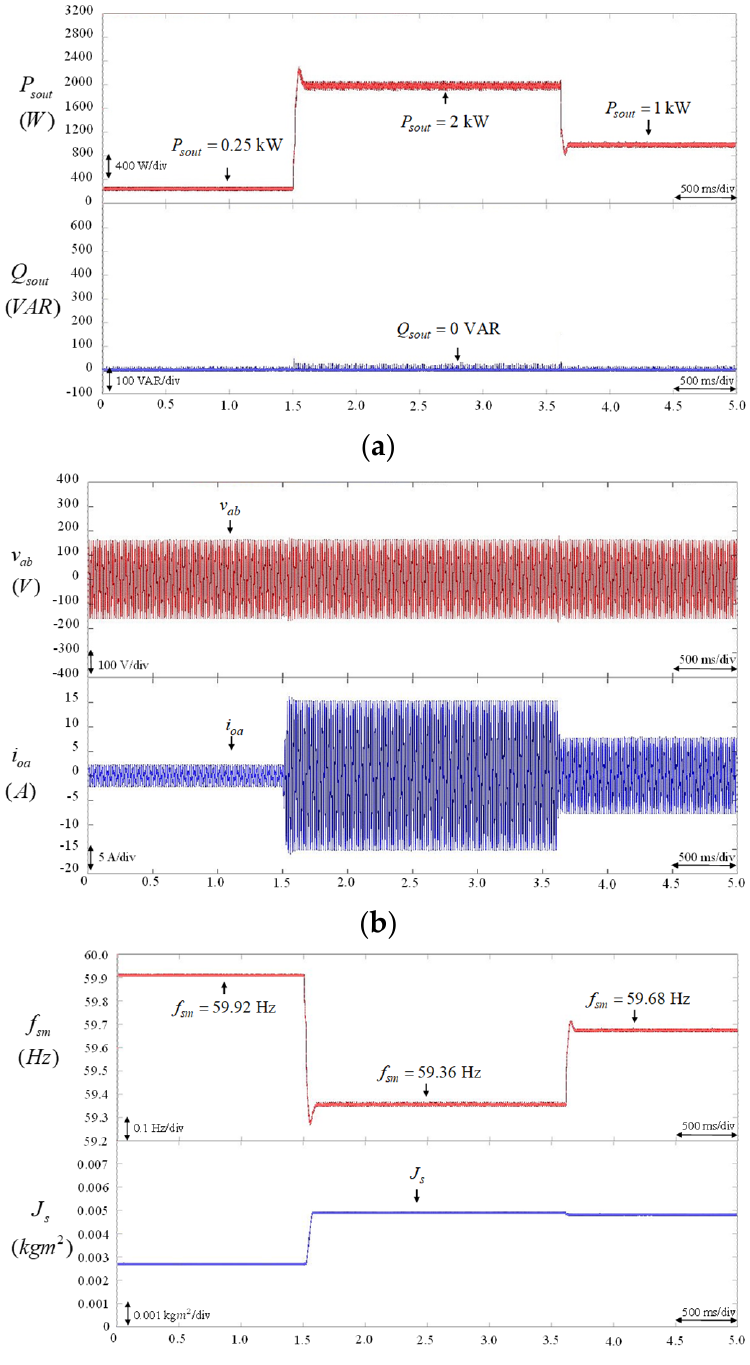
Figure 9. PI-controlled BESS using proposed virtual inertia estimator. ( a ) Responses of real power output P and reactive power output Q of BESS; ( b ) Responses of line-to-line voltage v sout output current i oa of BESS; ( c ) Responses of virtual rotor frequency f sm of VSG control and estimated virtual inertia J s